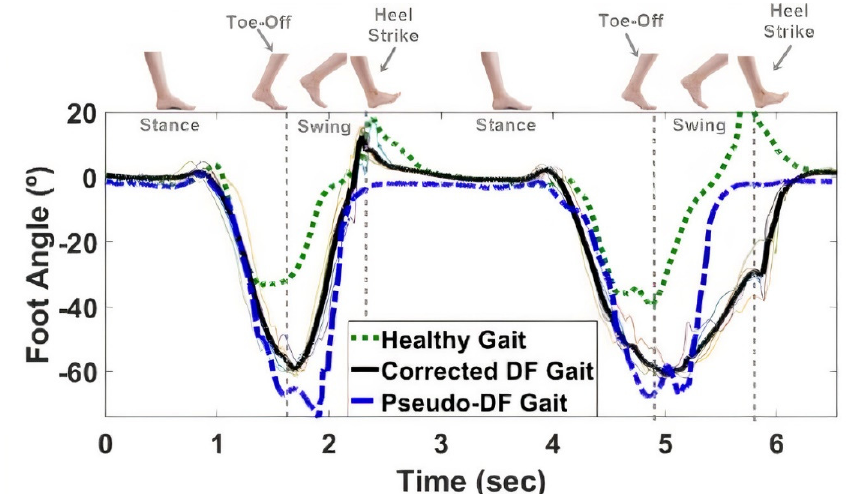
Figure 11. Foot angle obtained by measuring DF gait (blue line) in comparison with foot angle measured during DF correction (black line) using the feedback and feedforward control strategy at a walking speed of 1.5 km/h. The black line represents the average of all gait cycles obtained in DF correcting conditions. The green line represents a healthy foot angle trajectory.